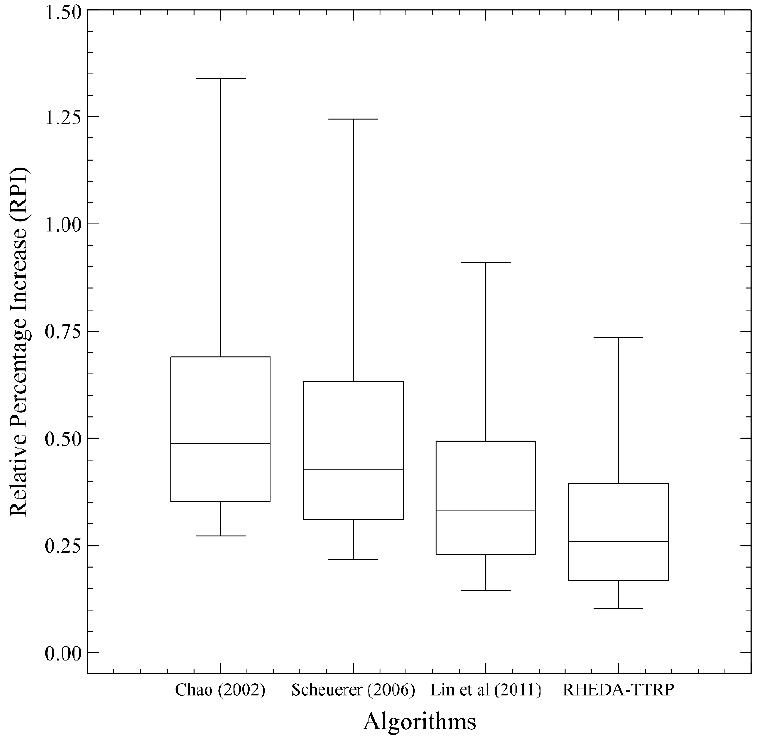
Figure 9. Algorithm Performance for the TTRP using the relative percentage increase [30,31,34].